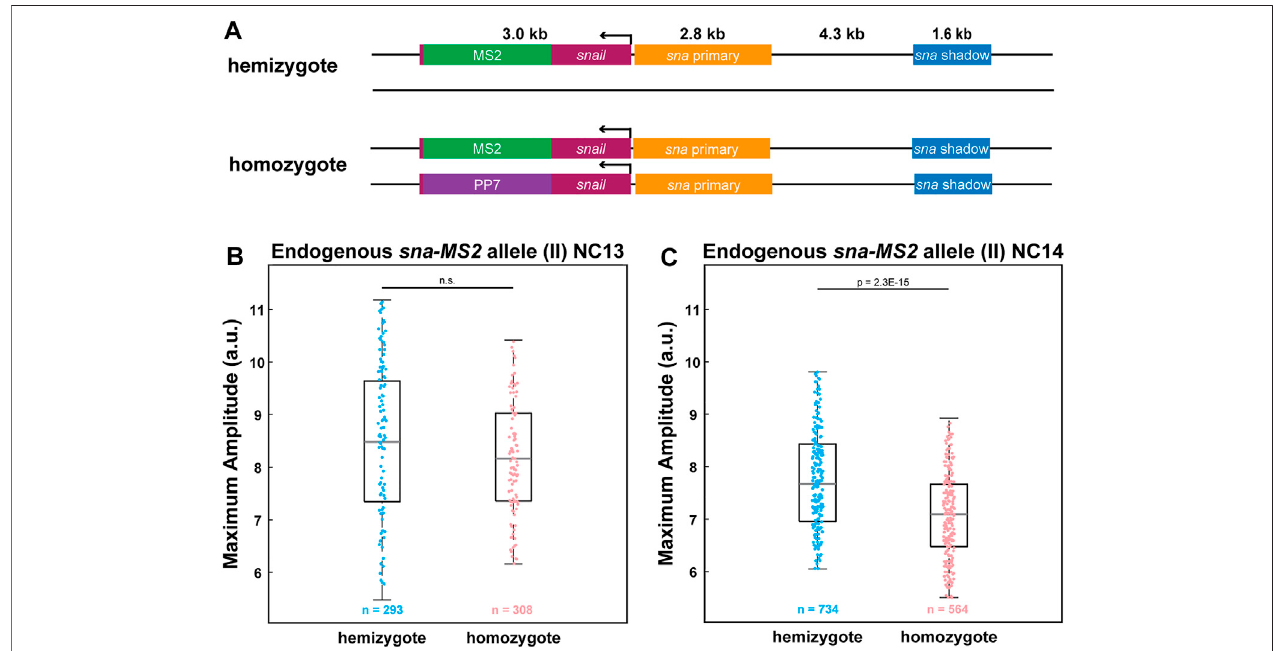
FIGURE4| Alleliccompetitionisobservedforendogenous sna . (A) Schematicofthehemizygousandhomozygousendogenous sna constructs.MS2orPP7stem loops are inserted into the 3 ′ UTR of the endogenous sna via CRISPR-mediated genome editing. (B – C) Boxplot of the transcriptional amplitude of the hemizygous and homozygous sna-MS2 alleles during (B) NC13 and (C) NC14. No allelic competition is observed in NC13. However, amplitude of the homozygous sna-MS2 allele is about 10% lower than the hemizygous allele ’ s amplitude in NC14. n indicates the number of analyzed nuclei from 2, 2, 3, and 3 biologically replicate embryos of each genotype, respectively . For boxplots in (B-C), the scatter points indicate values from 100 (B) or 200 (C) randomly selected nuclei used in the analysis. The box indicates the 25%, 50% and 75% quantile, and the whiskers extend to the 10th and the 90th percentile of each distribution.